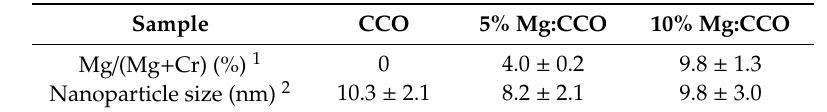
Figure 2. Energy-dispersive X-ray spectroscopy (EDX) spectra for ( a ) 5% Mg:CCO and ( b ) 10% Mg:CCO. Mappings of Mg element (inset) show uniform distribution. Table 2. Measured Mg doping concentration of CCO, 5% Mg:CCO, and 10% Mg:CCO films and Mg:CCO nanoparticles.